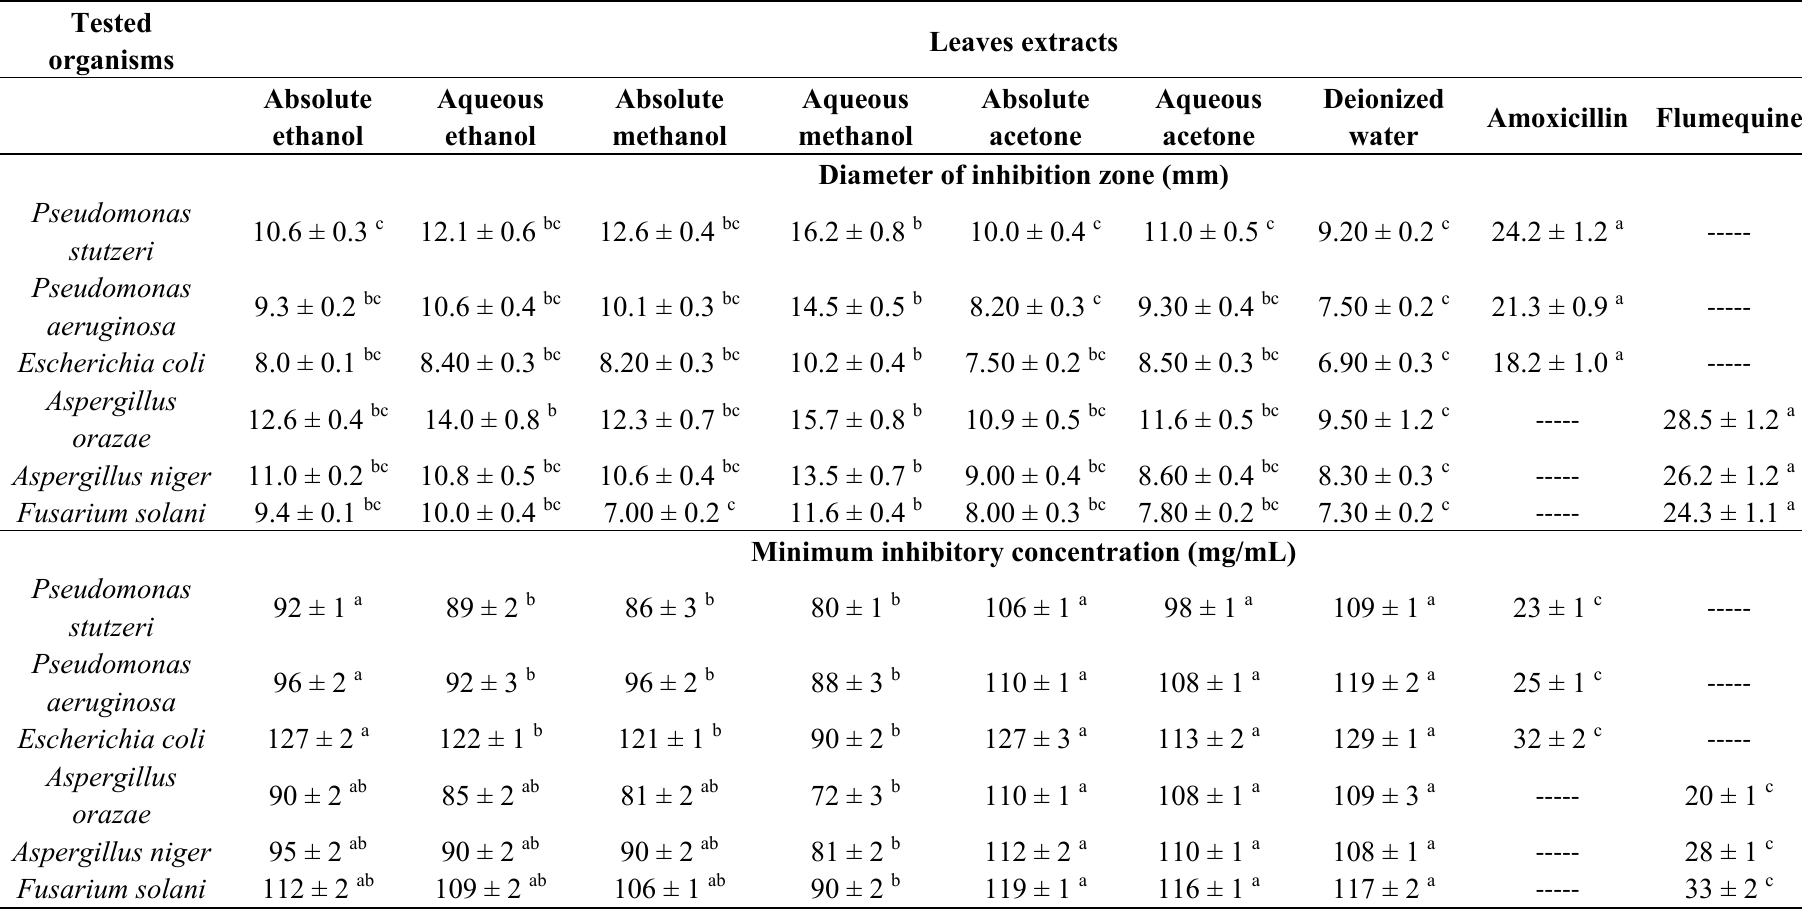
Values are mean ± SD of three separate experiments. Different superscript letters within the same row indicate significant ( p < 0.05) differences of means within the extracting